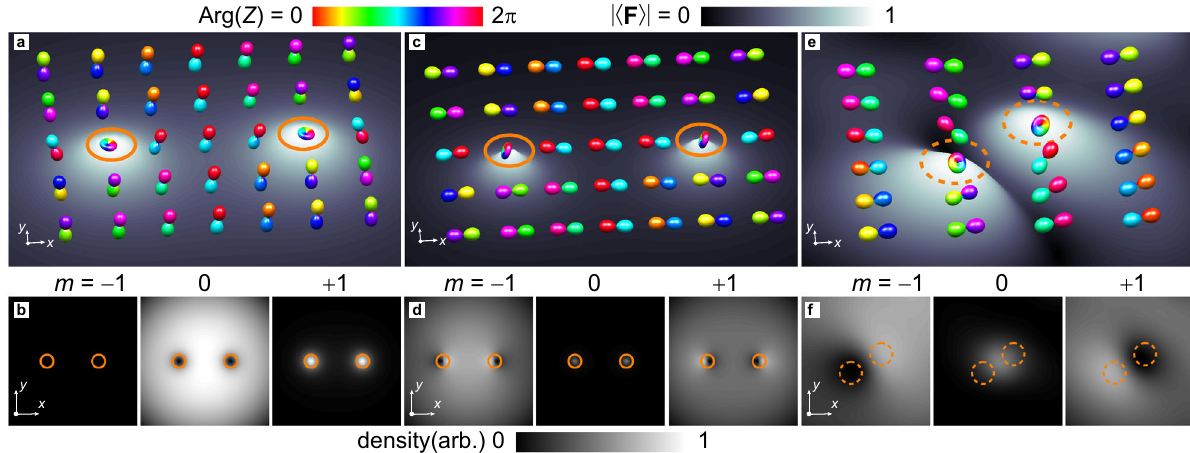
Y θ , ϕ ), parameterized by local 1, m (